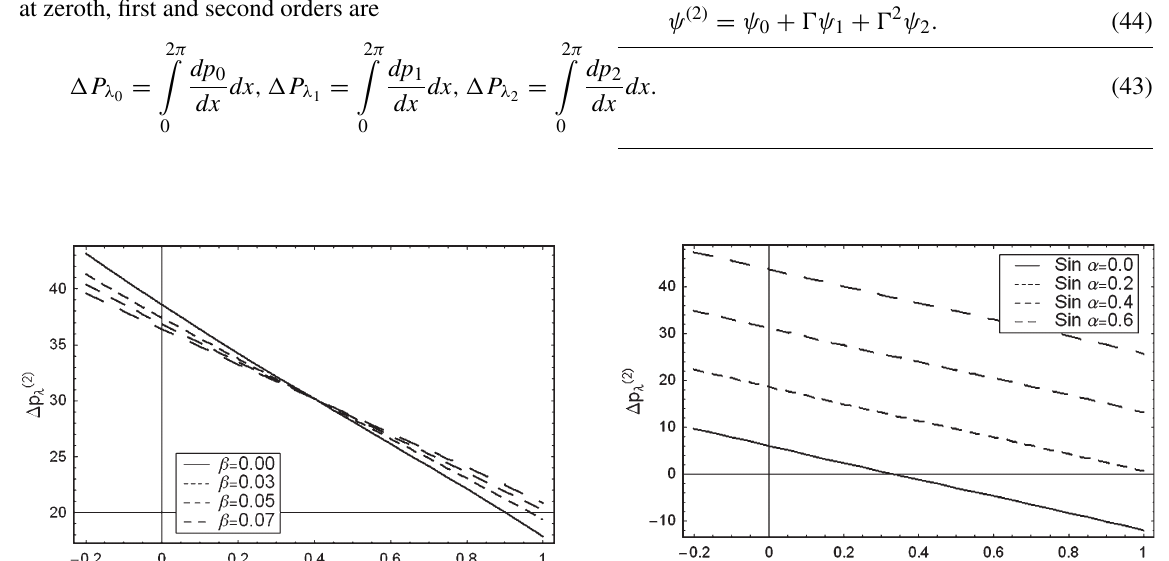
Fig. 4. Effect of inclined angle α on variation of (cid:16)p (2) with θ (2) for λ a = 0 . 2, b = 0 . 5, d = 0 . 7,Re = 10, (cid:15) = 0 . 04, Fr = 1, β = 0 . 1and φ = π/ 4.